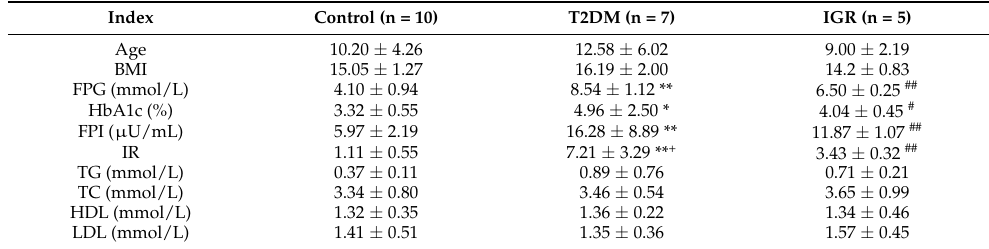
Table 1. Physiological and biochemical parameters of T2DM, IGR and healthy